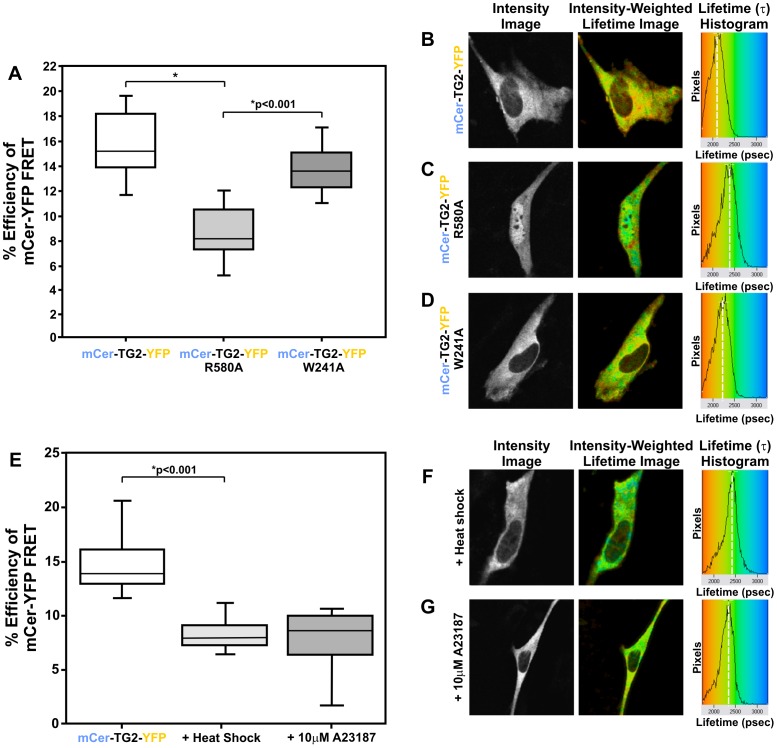
Point Mutations and Cell Stresses Affect TG2 Conformation in Live Cells.(A) Quantitative FLIM-FRET data shown as percent efficiency of FRET for the mCerulean-TG2-eYFP FRET sensor, GDP/GTP insensitive R580A mutant and catalytically inactive W241A mutant. Black line represents median values, boxes encompass 25% and 75% confidence intervals and whiskers indicate the 5% to 95% confidence intervals. *p<0.001. N = 15 for 4 replicates. (B–D) Representative FLIM images of data in (A). (E) Quantitative FLIM-FRET data shown as percent efficiency of FRET for the mCerulean-TG2-eYFP FRET sensor, or the sensor following either a 30 minute heat shock (42.5°C) treatment or a treatment with Ca2+ ionophore A23187 for 10 minutes. (F, G) Representative FLIM images of data in (E). *p<0.001. N>10 for 4 replicates. Scale bar represents 10 µm.